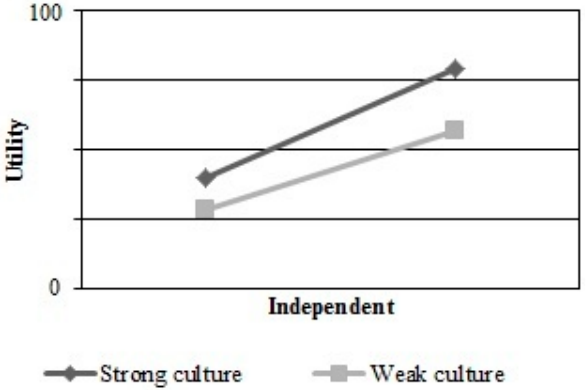
Figure 3. Moderating effect of the cultural context on the link between independent directors and Utility variable.